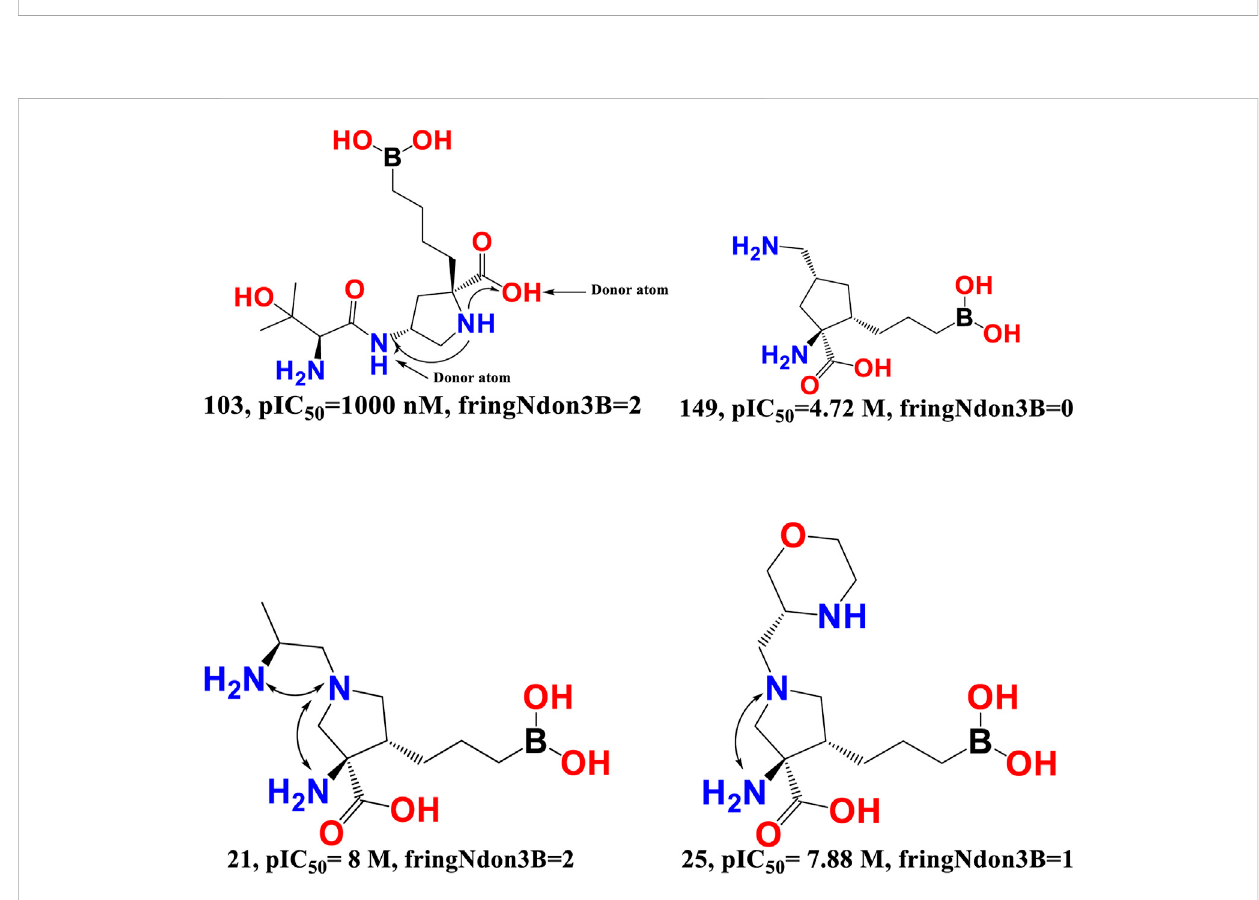
FIGURE 6 Presentation of the molecular descriptor fringNdon3B for the molecular pairs; 103 and 149, and for 21 and 25 only.